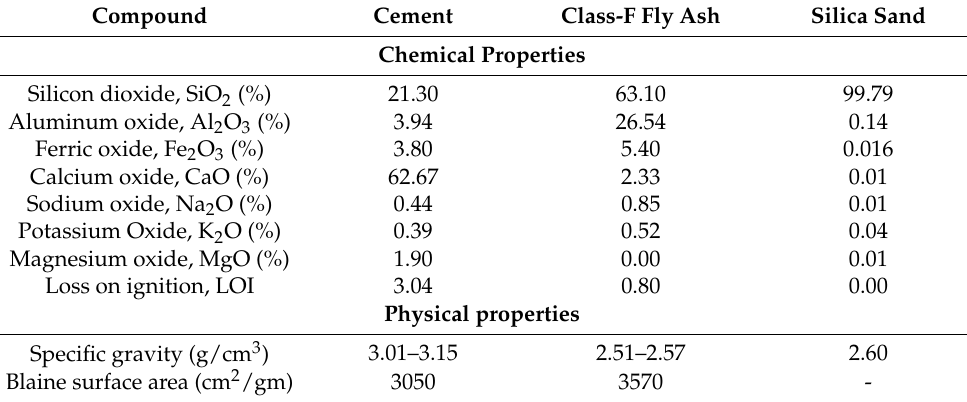
Table 1. Chemical and physical properties of cement and supplementary materials used in ECC mix. Compound